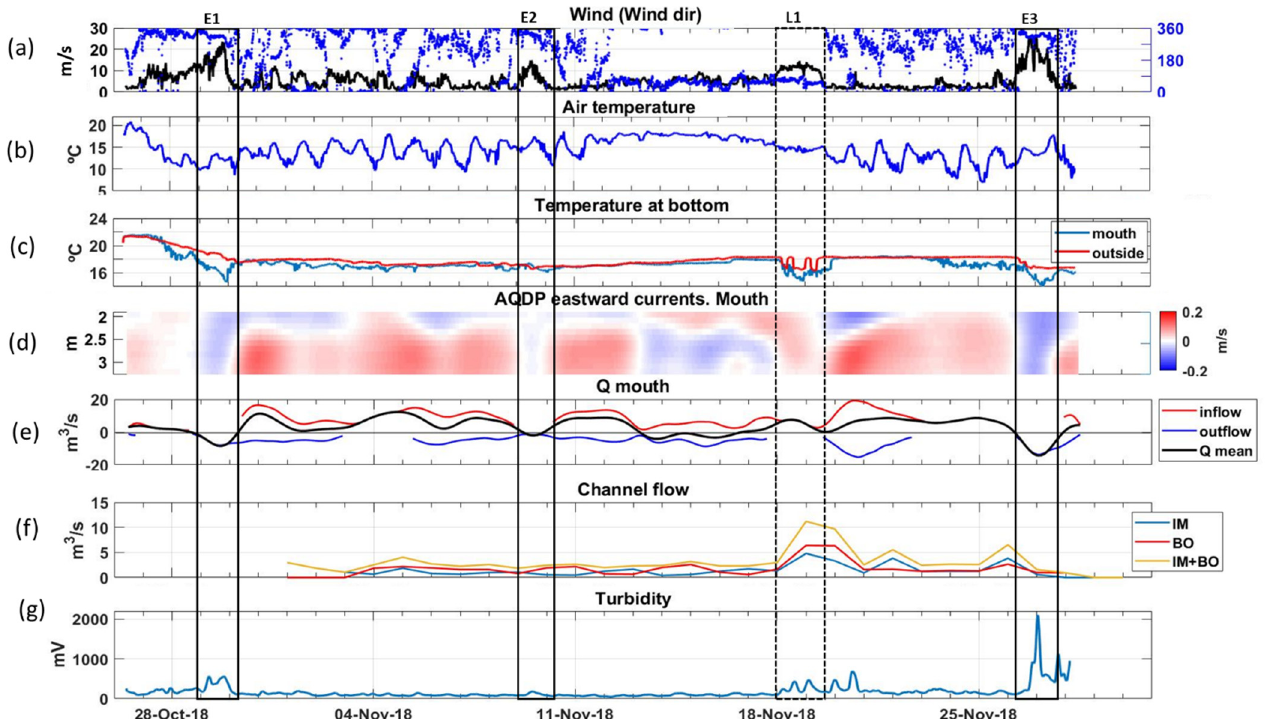
Figure 2. From top to bottom, wind intensity and direction ( a ), air temperature ( b ), bottom water temperature ( c ) alongshore currents in mouth ( d ), inflow (positive) and outflow (negative) of bay ( e ), flow of the discharge channels ( f ), turbidity ( g ). The black boxes show the events of the NW, and the dotted black boxes show the events of the E, from 26 October to 28 November 2018 (FANGAR-III). E1: 29–30 October; E2: 9–10 November; L1: 18–20 November; E3: 27–29 November.